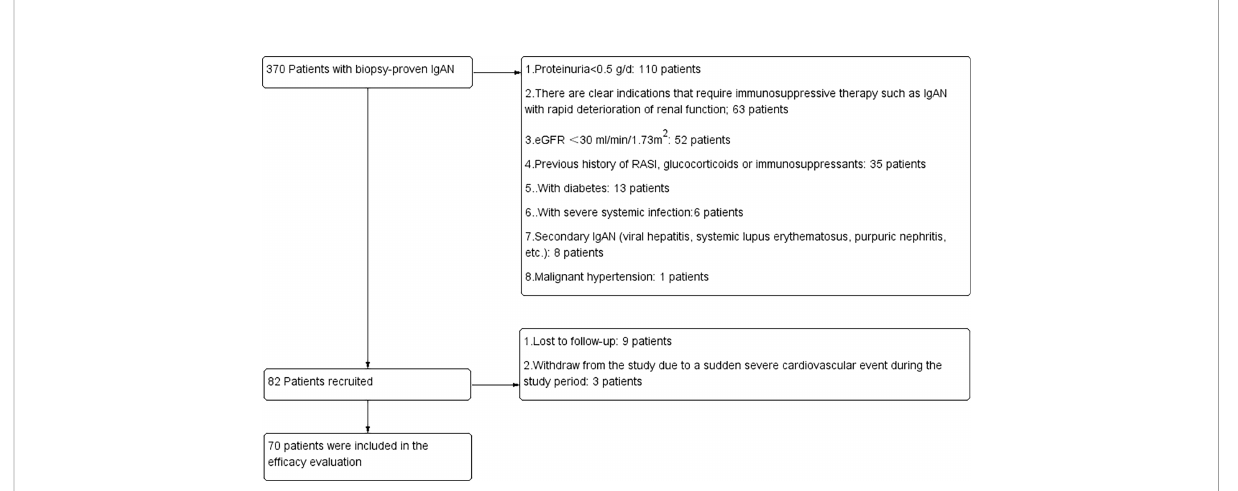
FIGURE 1 Details of patients screened, recruited and included in the fi nal analysis. RASi, renin-angiotensin system inhibitors; eGFR, estimated glomerular fi ltration